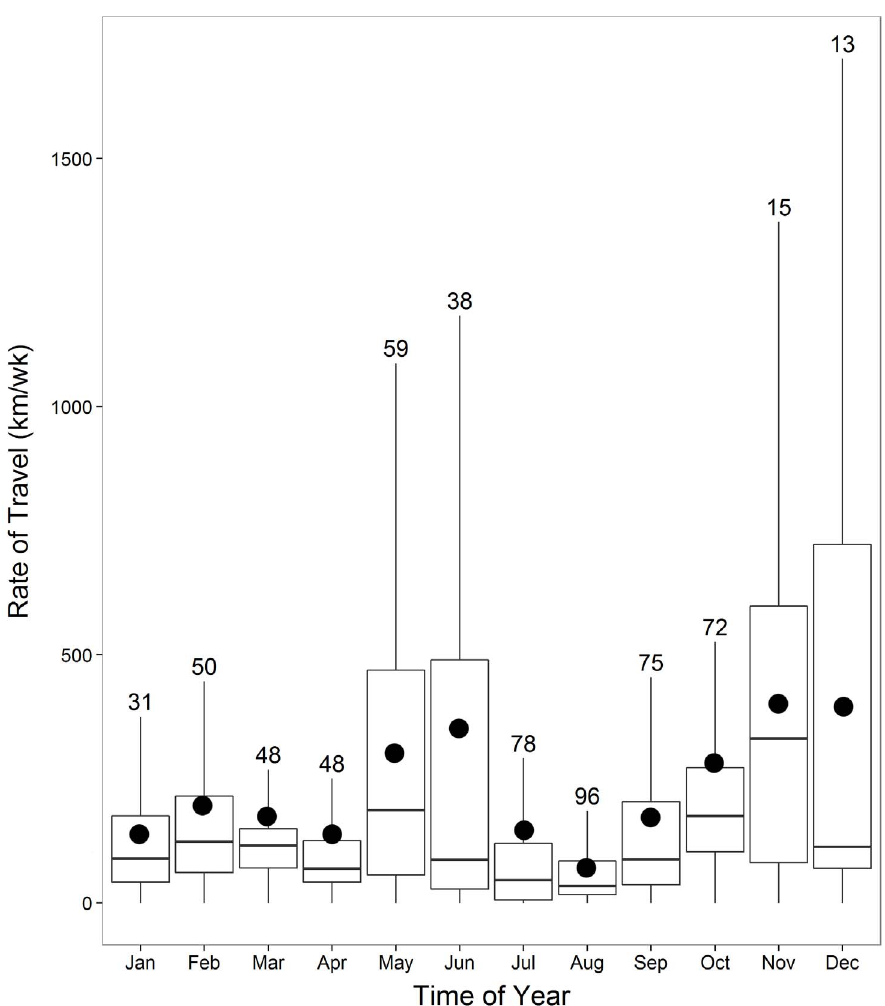
Fig. 6. Weekly rates of travel (km/wk) per month. Box plots show median and 25 th and 75 th quartiles for all satellite-tagged ivory gulls throughout the study period, July 2010- July 2013. Whiskers represent values within 1.5 times the interquartile range. Mean values are depicted by the black circles. Note small sample sizes for November and December due to too few records during the blackout period for the